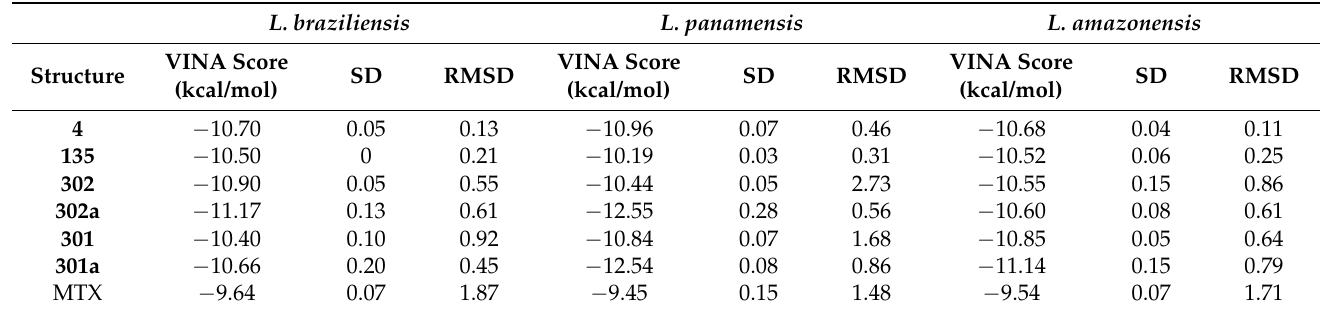
Table 3. The VINA score values for six tested structures and MTX (methotrexate) for dihydrofolate reductase-thymidylate synthase (DHFR-TS) of Leishmania braziliensis , Leishmania panamensis , and Leishmania amazonensis . SD = standard deviation; RMSD values = root-mean-square deviation. L. braziliensis